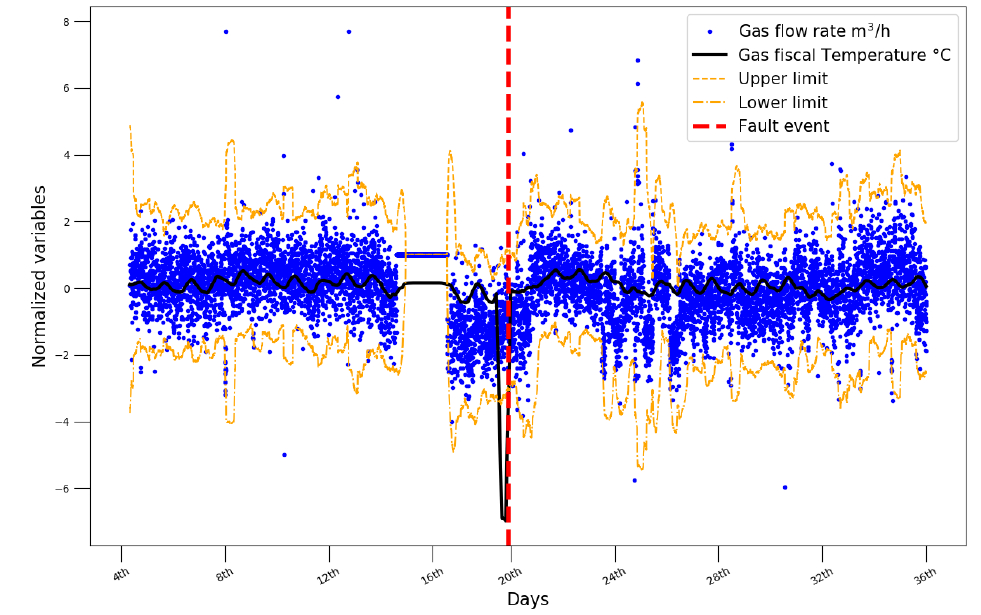
Figure 4. Control chart using a univariate monitoring